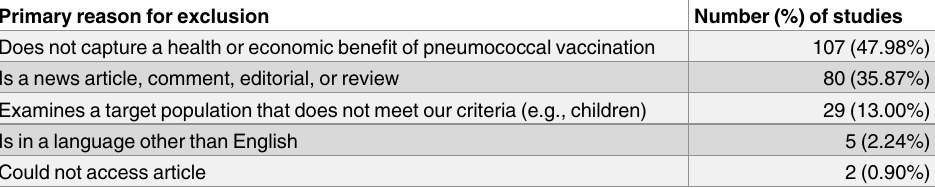
Table 2. Summary of primary reasons for study exclusion after full text review.